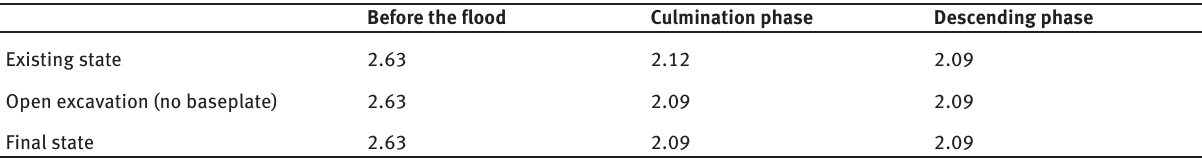
Fig. 14 Failure mode during culmination of the flood. Figure 14: Failure mode during culmination of the flood. Table 3: Obtained values of SF for deep